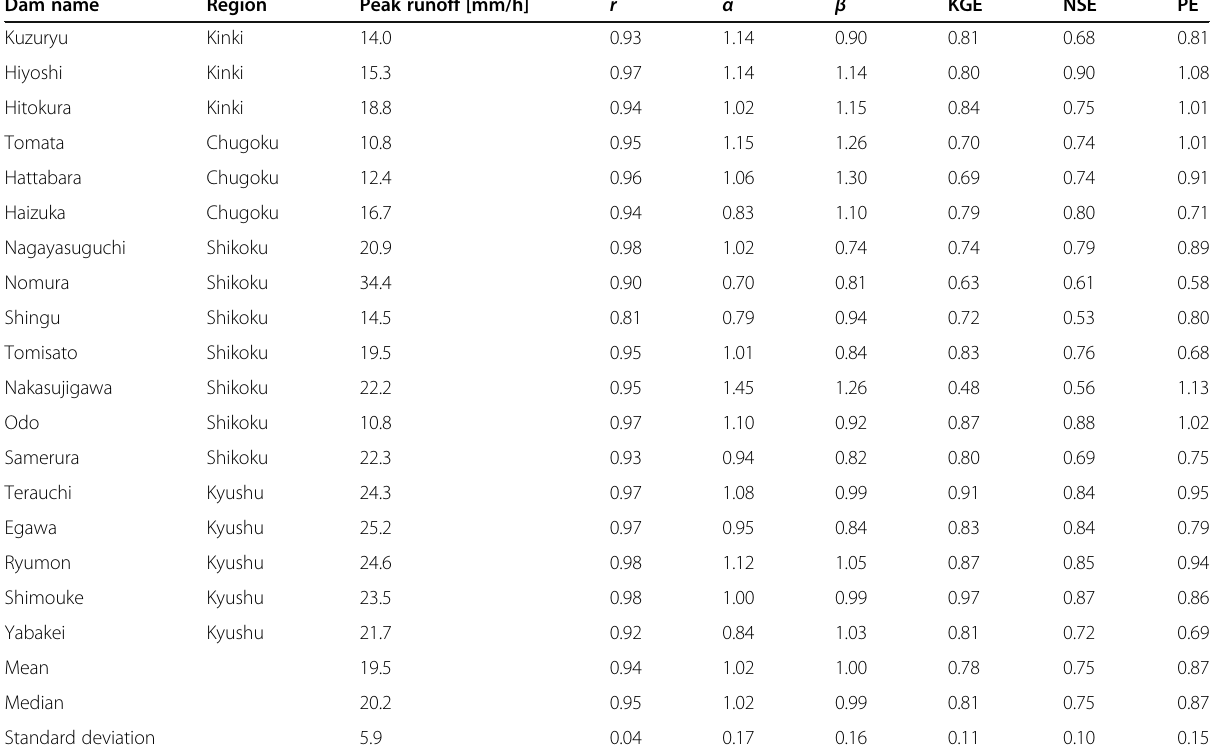
Table 2 Values of the verification metrics for the F18 simulation at each dam